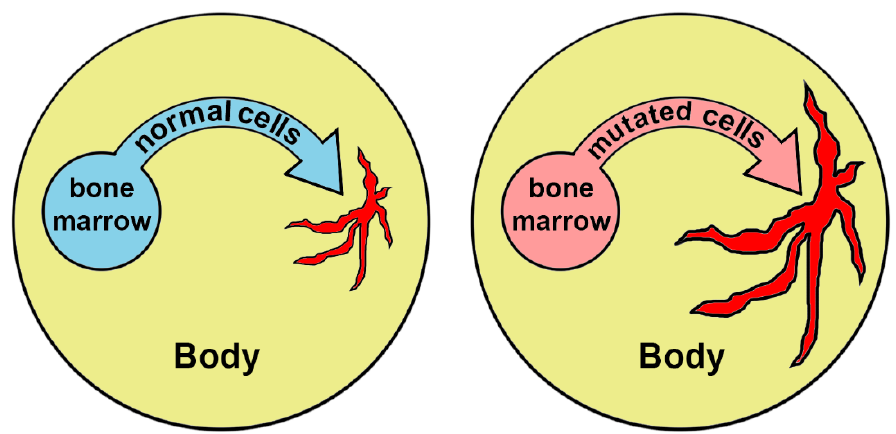
Figure 3. Extension and chronification of inflammation under the influence of hematopoietic cells carrying mutations. Areas of inflammation are marked in red.